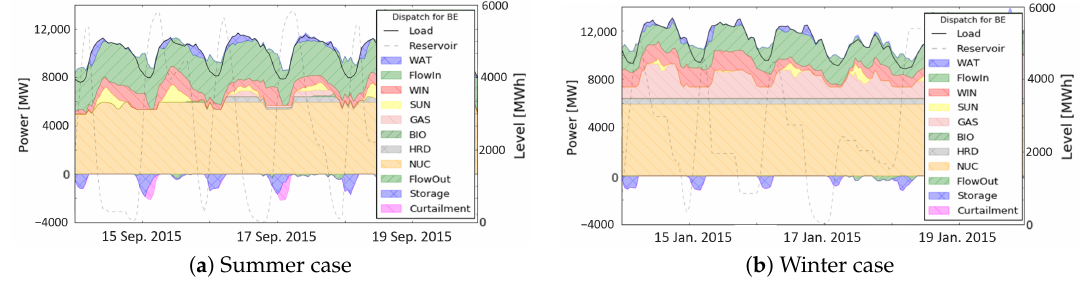
Figure 4. Optimal